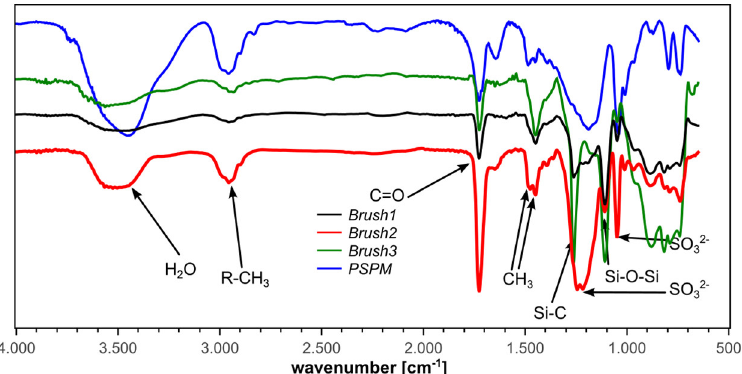
Figure 3. Infrared reflection absorption spectra (IRRAS) of the polymer brushes Brush1, Brush2, Brush3, and a Fourier-transform infrared (FTIR) spectrum of free (non-surface-grafted) poly(3-sulfopropyl methacrylate) potassium salt (PSPM) for comparison.